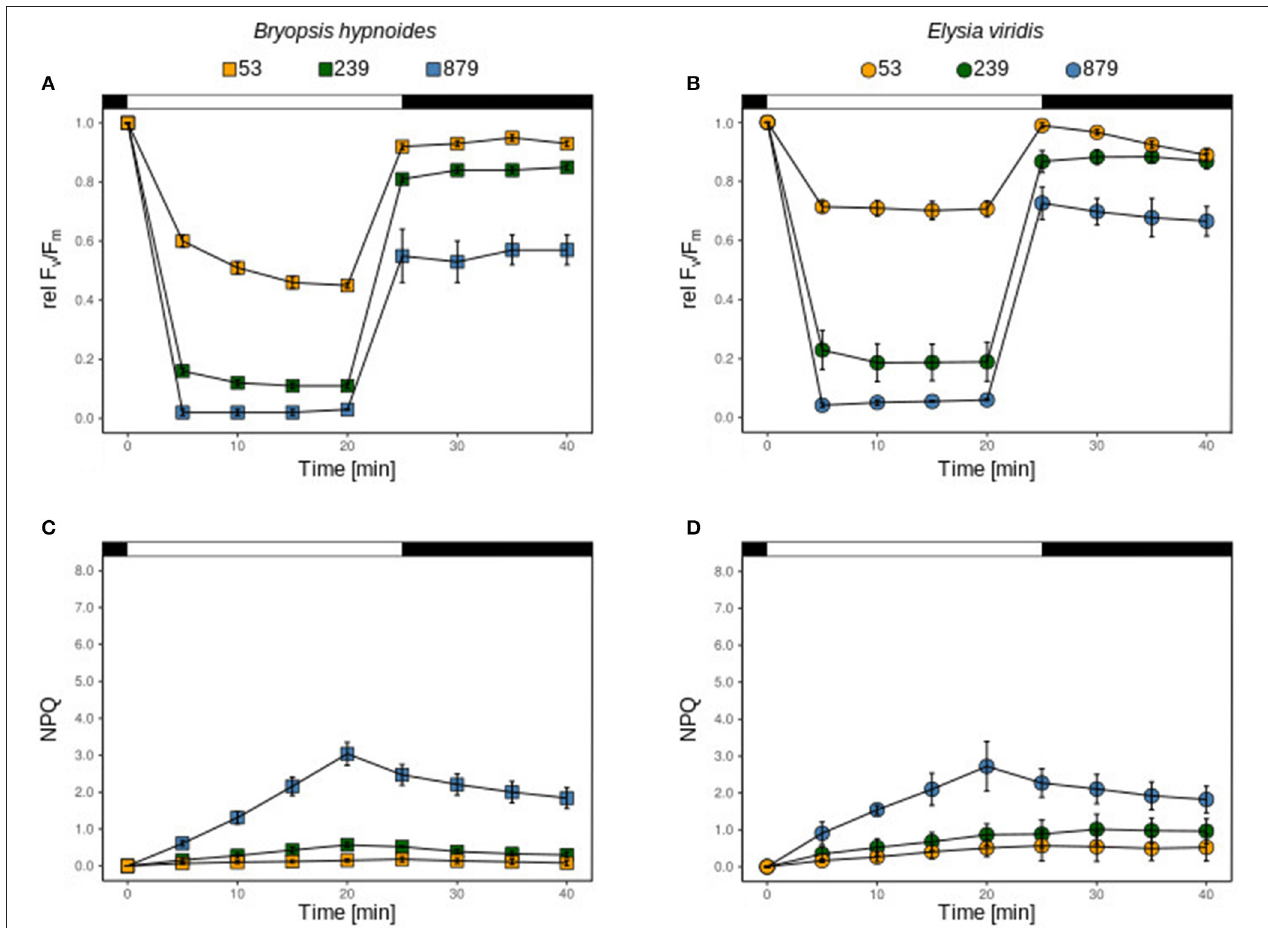
FIGURE 1 | relF v /F m and NPQ of chloroplasts of B. hypnoides (A,C) and kleptoplasts of freshly fed E. viridis (B,D) under three different light intensities (53, 239, and 879 µ mol photons m − 2 s − 1 ). The bar represents the dark acclimation phase (first black part), the light exposure time (white part) and the recovery phase (second black part). All measurements were performed in biological triplicates and error bars show the standard deviation.